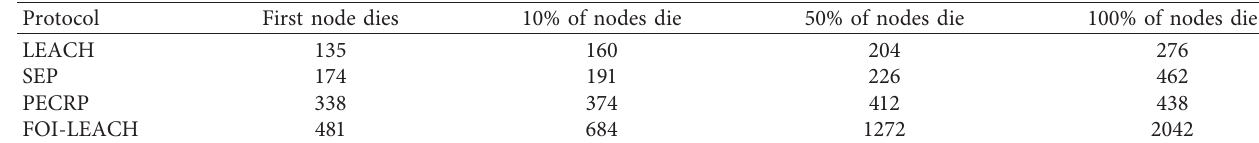
Table 2: Statistics number of rounds of dead nodes of the four protocols without power